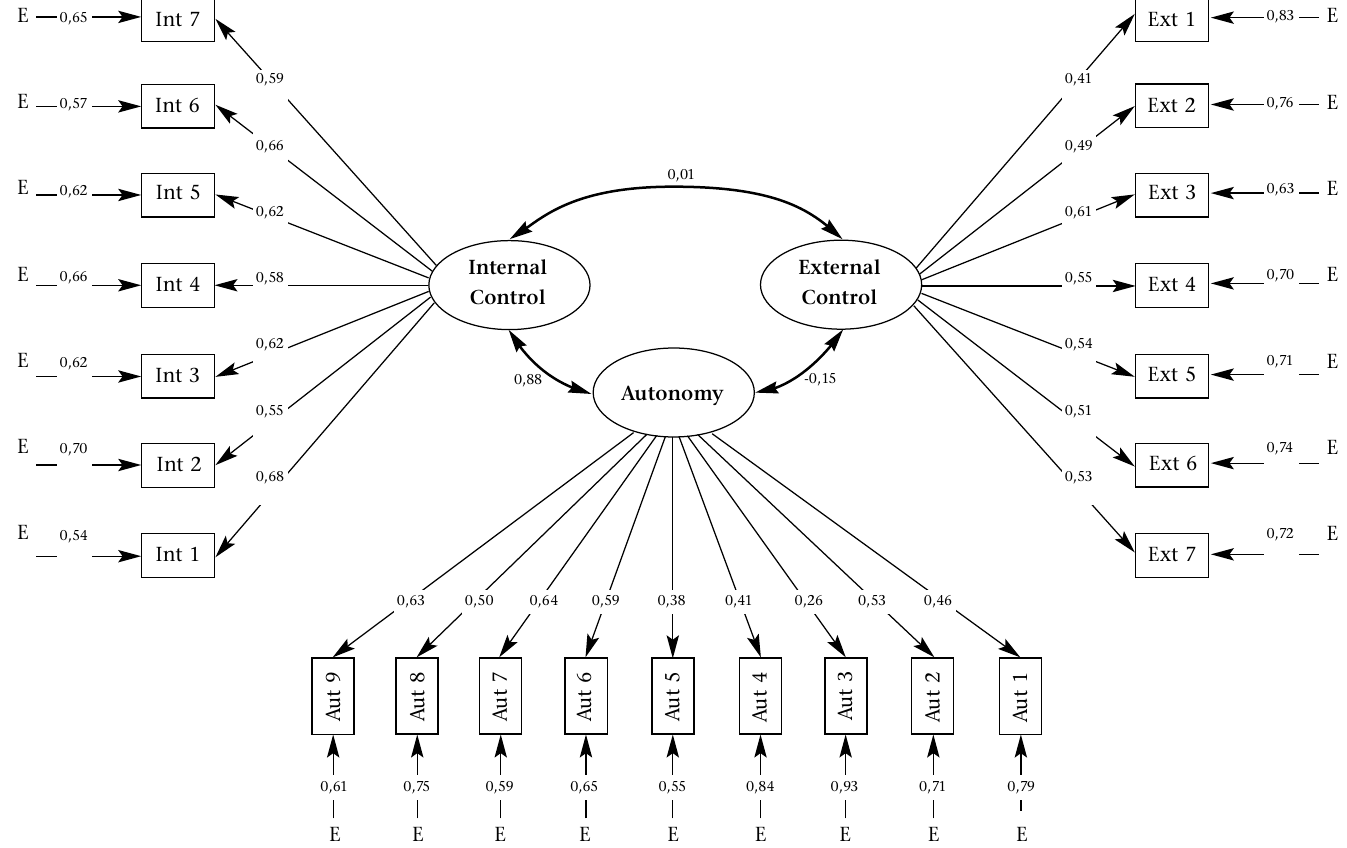
Figure 3: Standardised estimated parameters for the three-factor LCI model in respect of the Black